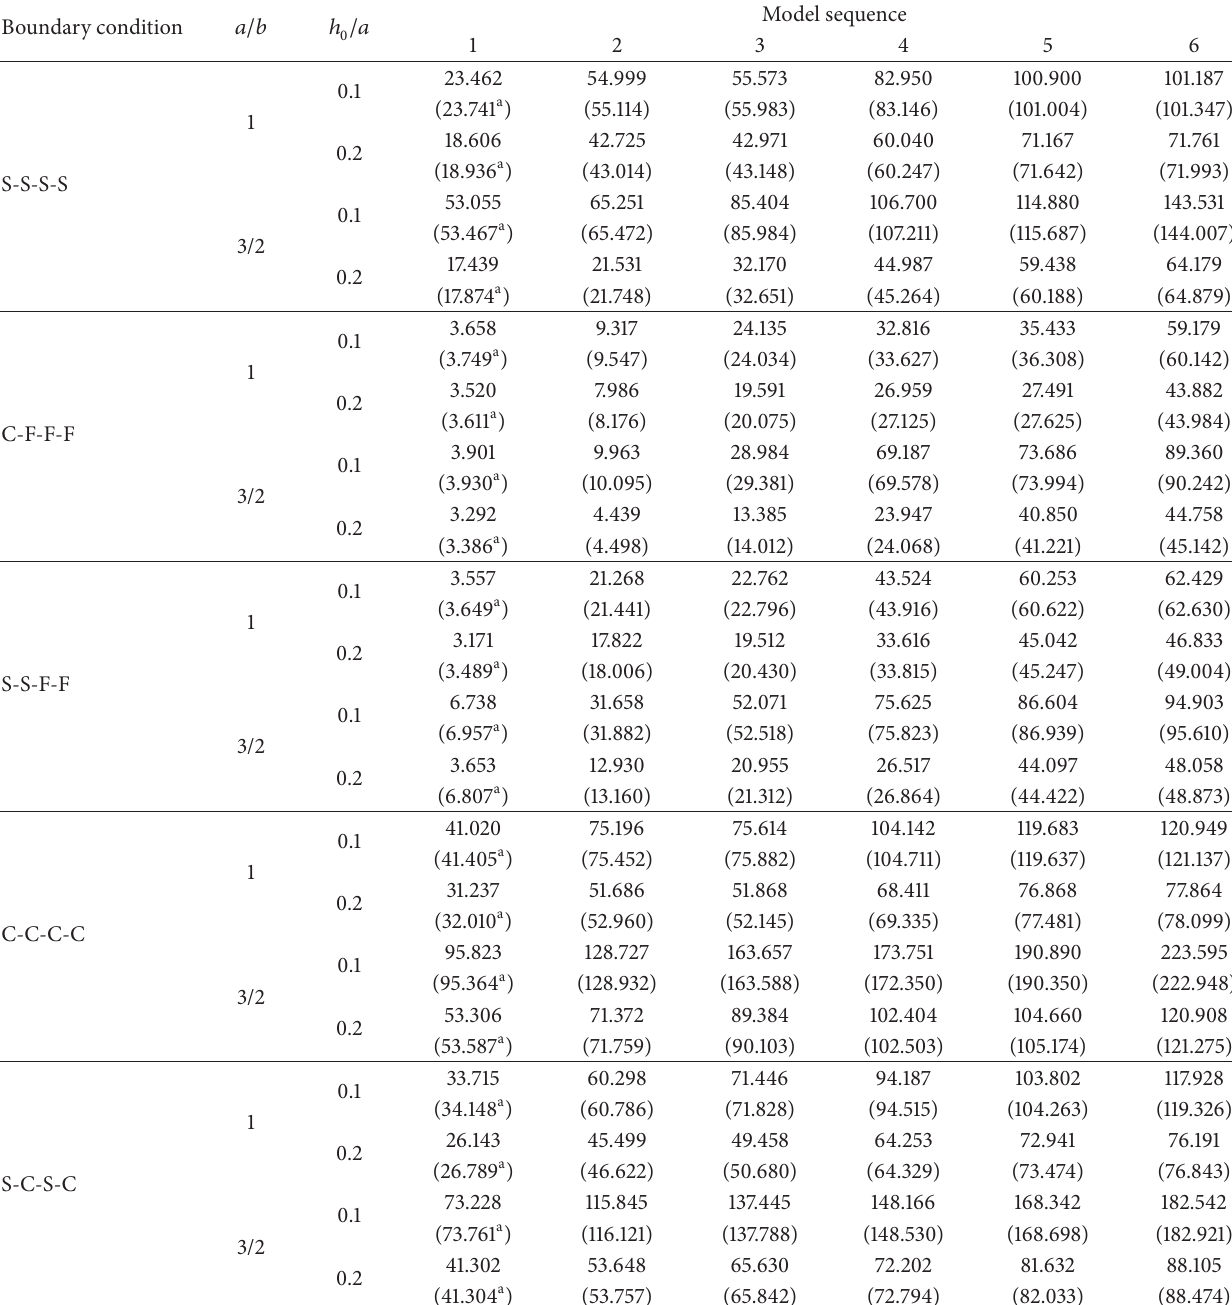
Table 9: Frequency parameter Ω = 𝜔𝑎 2 (𝜌ℎ 0 /𝐷 0 ) 1/2 for moderately thick plates with linearly varying thickness in different